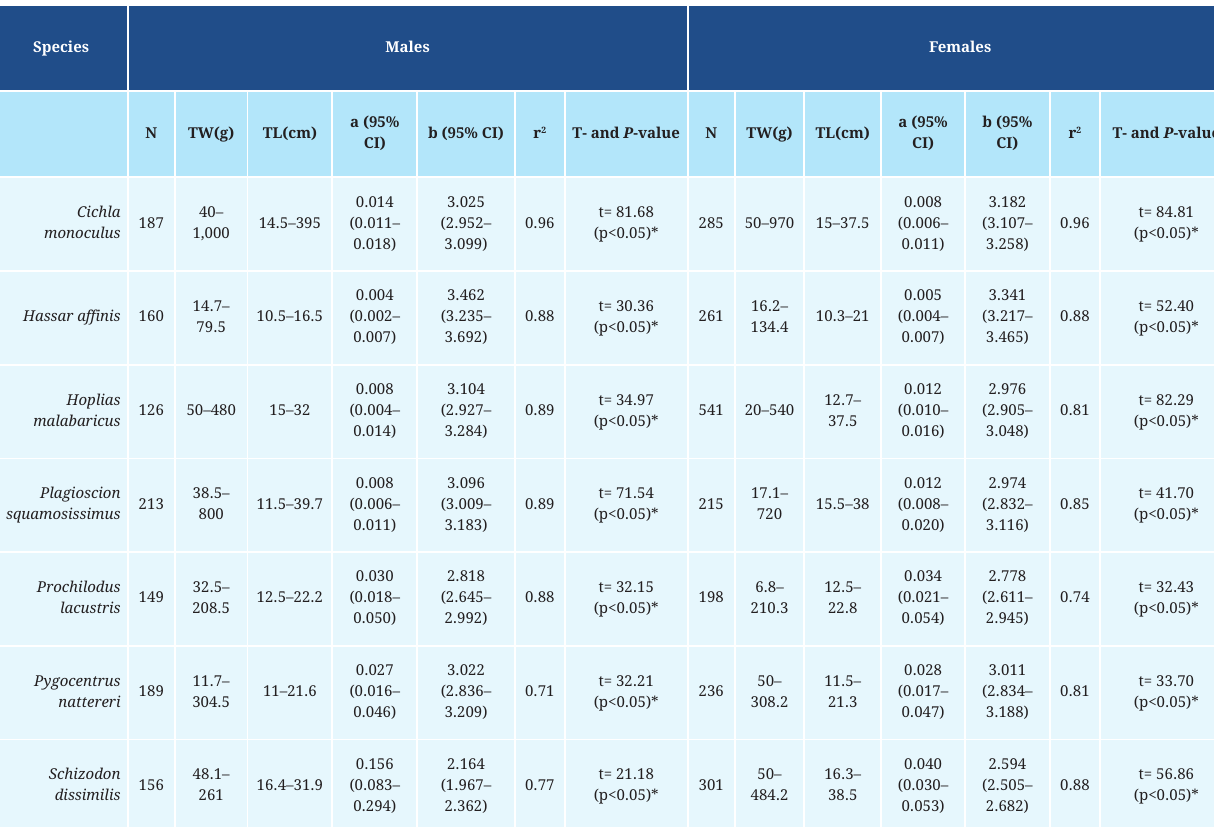
TABLE 1 | Weight-length relationship parameters for males and females by species caught in Baixada Maranhense Protection Area, Legal Amazon, between January 2012 and December 2016. TW = Total weight; TL = Total length; a = the linear regression coefficient; b = slope of regression; CI = Confidence intervals; r² = Coefficient of determination. Asterisks indicate that B-values are significantly different from 3, using Student's T statistic with p < 0.05.